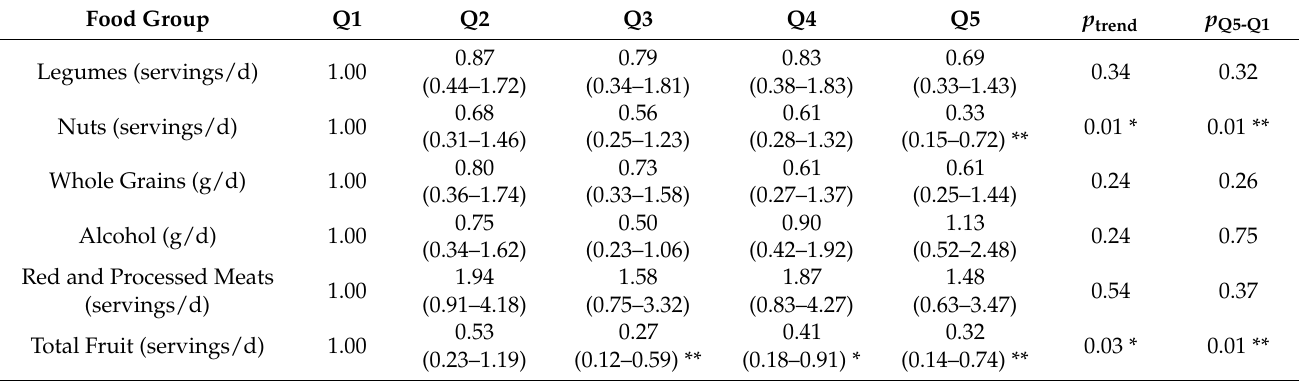
Table 5. Multivariable a ORs and 95% CI for association between quintiles of select food groups and nutrient